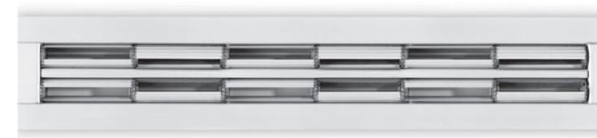
Fig. 3 . NSAL diffuser